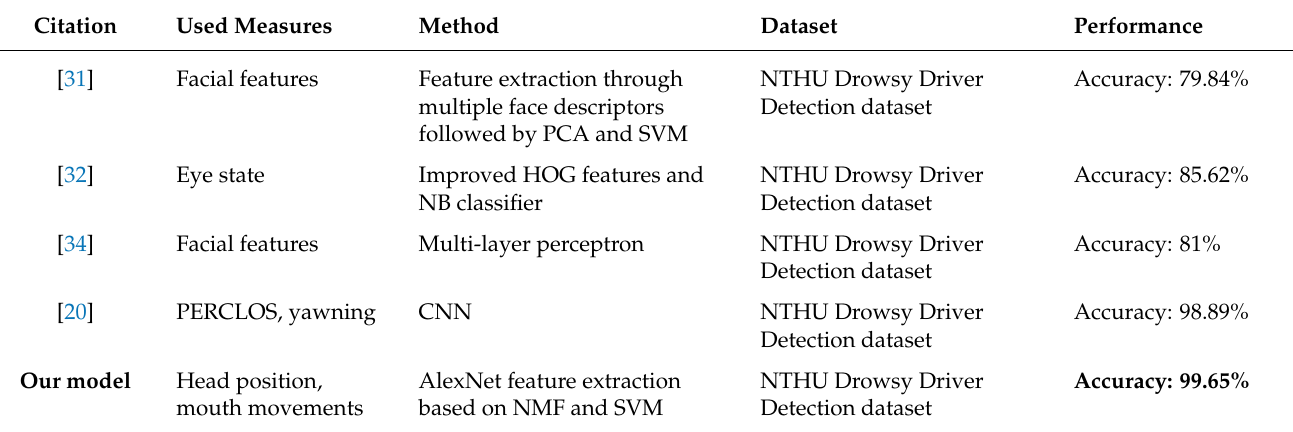
Table 11. Comparing our model with other